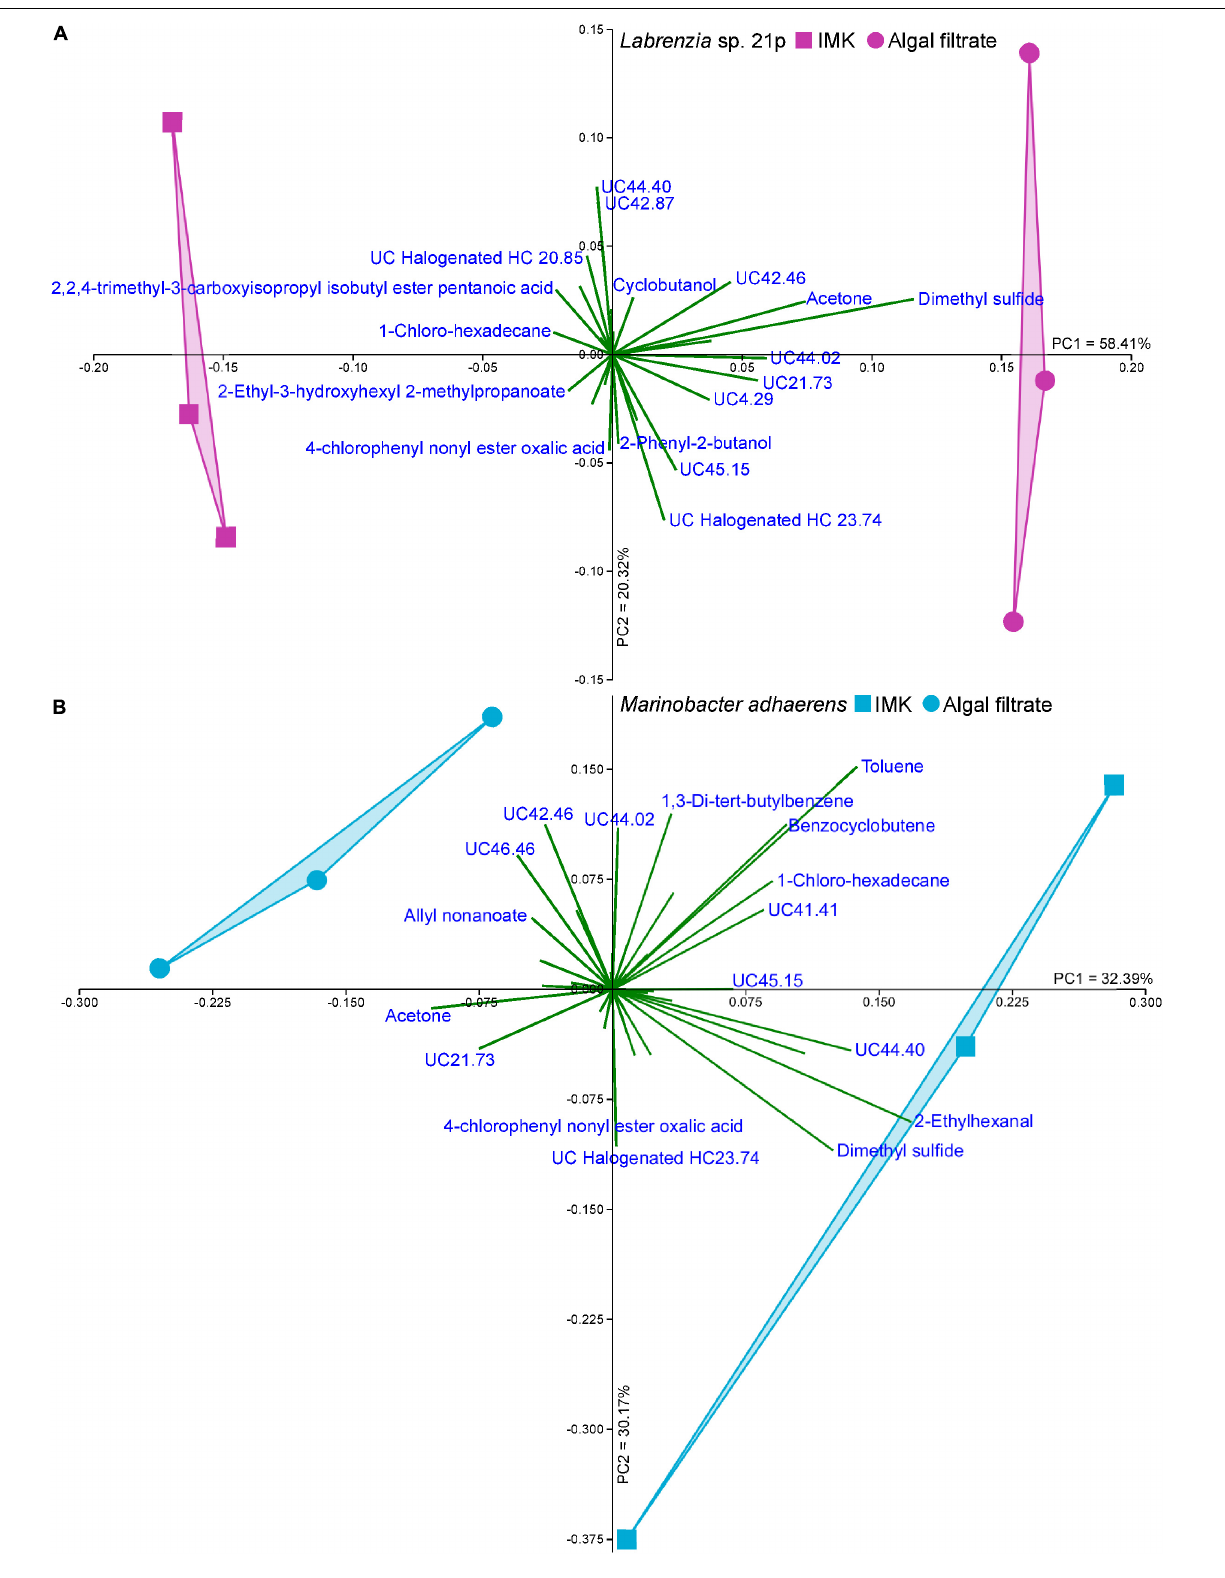
Frontiers in Marine Science |